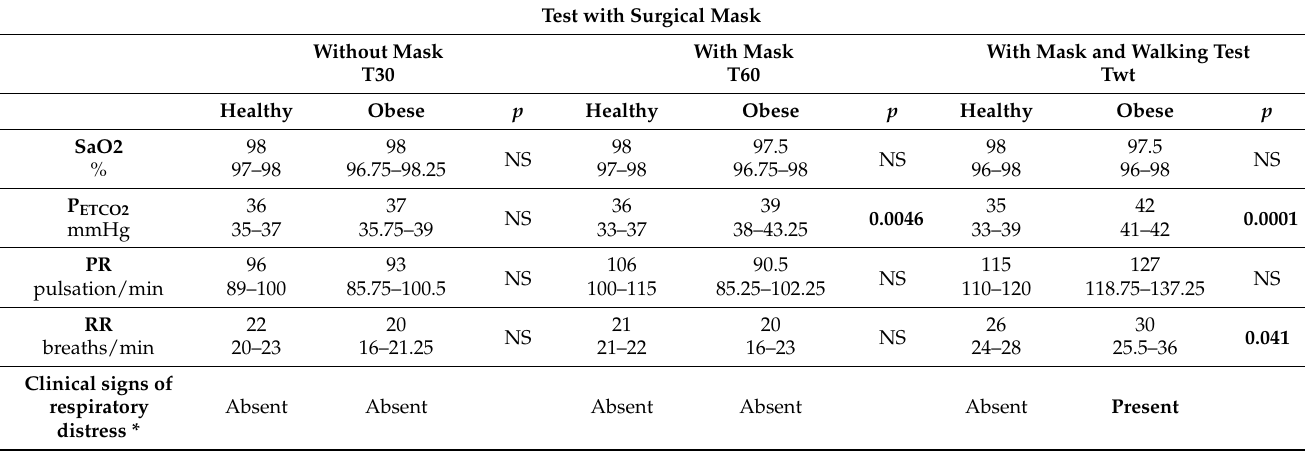
Table 4. Comparison between the group of healthy children and the group of overweight and obese children wearing a surgical mask. All data were expressed as median, 25th, and 75th quartile. Test with Surgical Mask With Mask